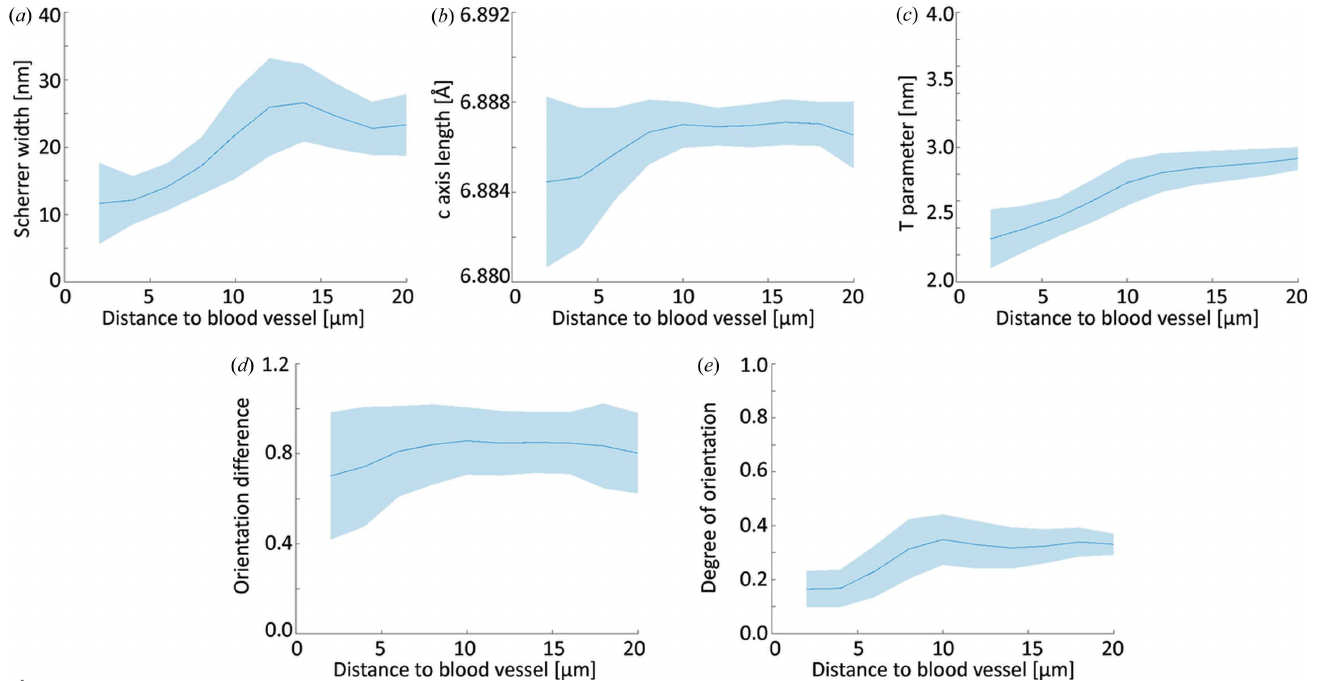
Figure 3 Nanostructural and crystallographic parameters plotted against the distance to the nearest blood vessel as determined by SAXS/WAXS-CT [panels ( a )– ( c )] and SAXS/WAXS-TT [panels ( d ) and ( e )]. ( a ) Apparent crystallite size along the c axis (Scherrer width). ( b ) Length of the HAP c axis. ( c ) T parameter of the mineral particles. ( d ) Squared dot product of the SAXS and WAXS tensors. ( e ) Degree of orientation determined by